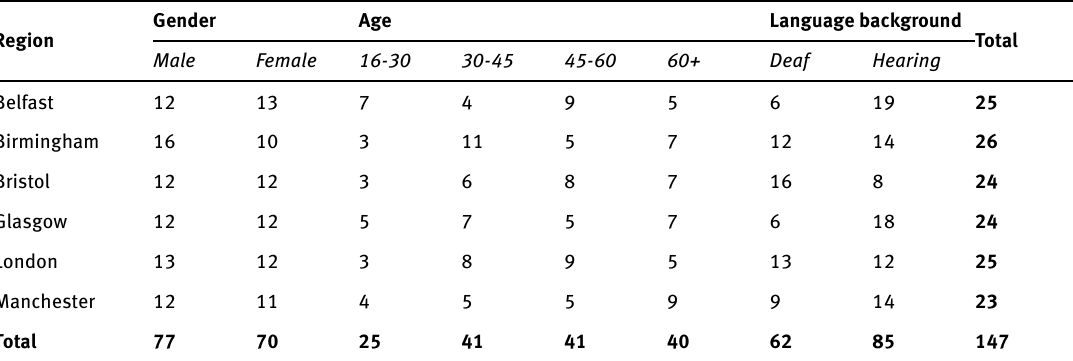
Table 1: Distribution of participants according to social categories